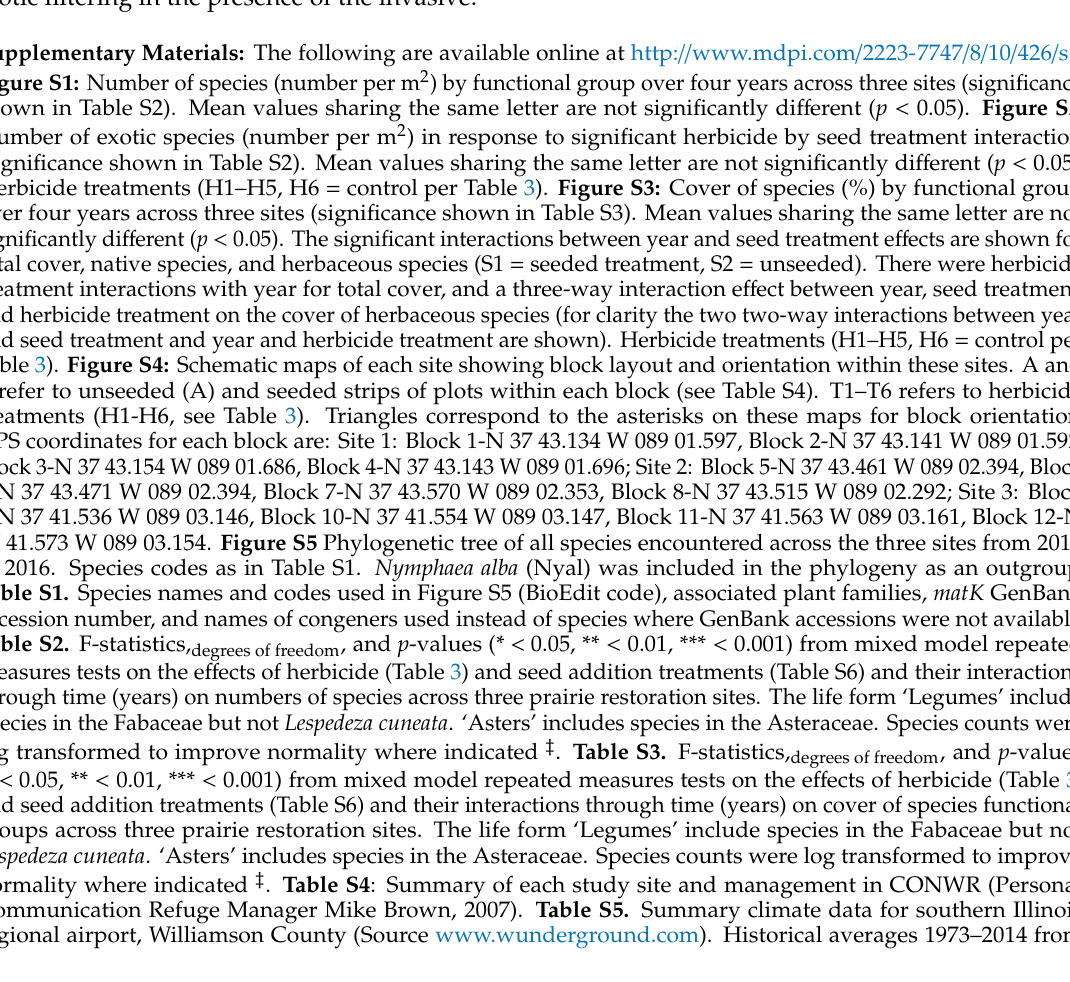
to 2016. Species codes as in Table S1. Nymphaea alba (Nyal) was included in the phylogeny as an outgroup. Table S1. Species names and codes used in Figure S5 (BioEdit code), associated plant families, matK GenBank accession number, and names of congeners used instead of species where GenBank accessions were not available. Table S2. F-statistics, degrees of freedom , and p -values (* < 0.05, ** < 0.01, *** < 0.001) from mixed model repeated measures tests on the e ff ects of herbicide (Table 3) and seed addition treatments (Table S6) and their interactions through time (years) on numbers of species across three prairie restoration sites. The life form ‘Legumes’ include species in the Fabaceae but not Lespedeza cuneata . ‘Asters’ includes species in the Asteraceae. Species counts were log transformed to improve normality where indicated ‡ . Table S3. F-statistics, degrees of freedom , and p -values (* < 0.05, ** < 0.01, *** < 0.001) from mixed model repeated measures tests on the e ff ects of herbicide (Table 3) and seed addition treatments (Table S6) and their interactions through time (years) on cover of species functional groups across three prairie restoration sites. The life form ‘Legumes’ include species in the Fabaceae but not Lespedeza cuneata . ‘Asters’ includes species in the Asteraceae. Species counts were log transformed to improve normality where indicated ‡ . Table S4 : Summary of each study site and management in CONWR (Personal Communication Refuge Manager Mike Brown, 2007). Table S5. Summary climate data for southern Illinois regional airport, Williamson County (Source www.wunderground.com). Historical averages 1973–2014